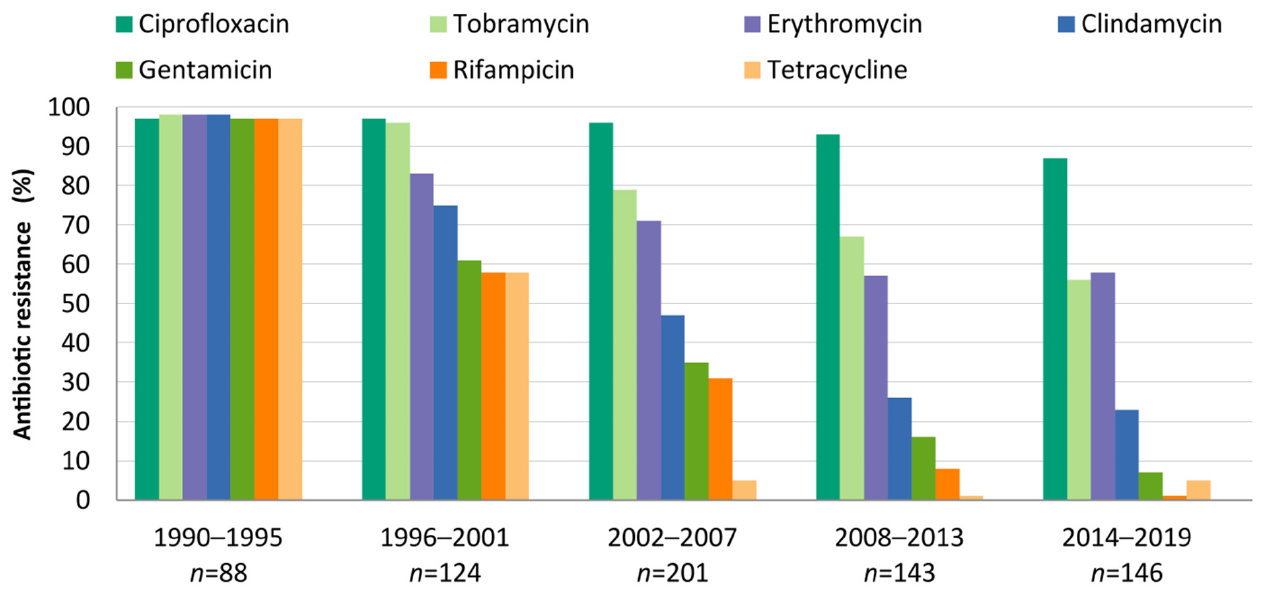
Figure 3. Evolution of antimicrobial resistance rates by period . Only antimicrobials with re- sistance rates above 5% are shown. All decreases in the percentages of antibiotic resistance were statistically significant ( p < 0.01) when comparing the first (1990–1995) and the last periods (2014–